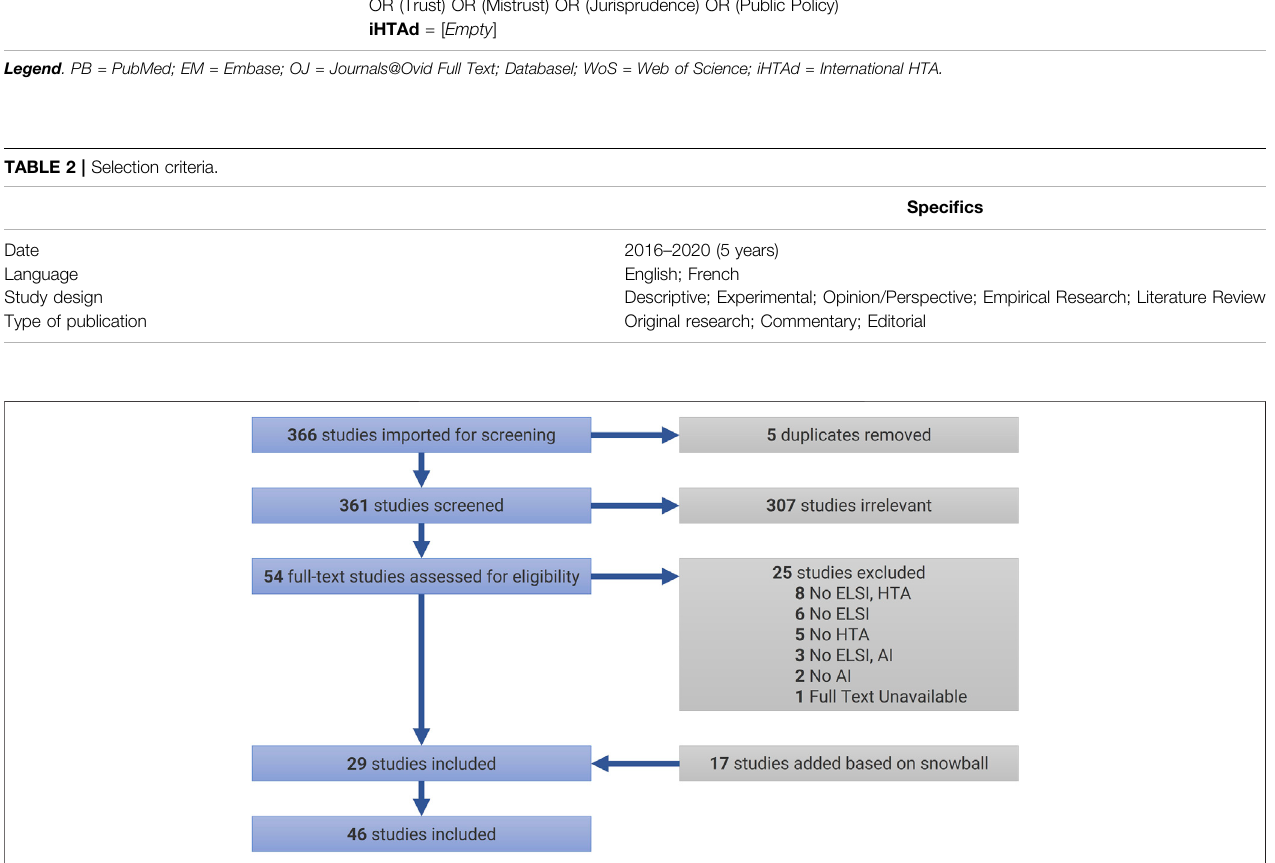
Frontiers in Arti fi cial Intelligence |